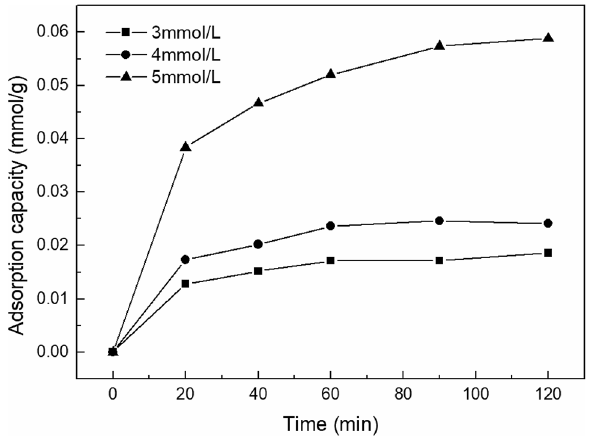
Figure 1. Adsorptive capacity of SDBS on kaolinite at various SDBS concentration under different adsorption time.